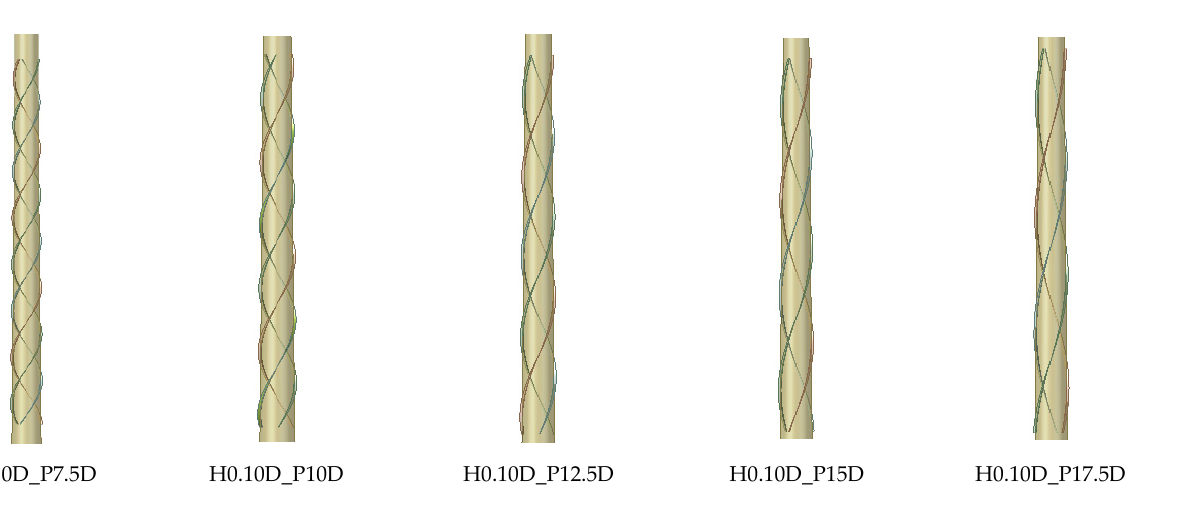
Figure 17. Different pitches of the high-mast light pole with spiral side plates.